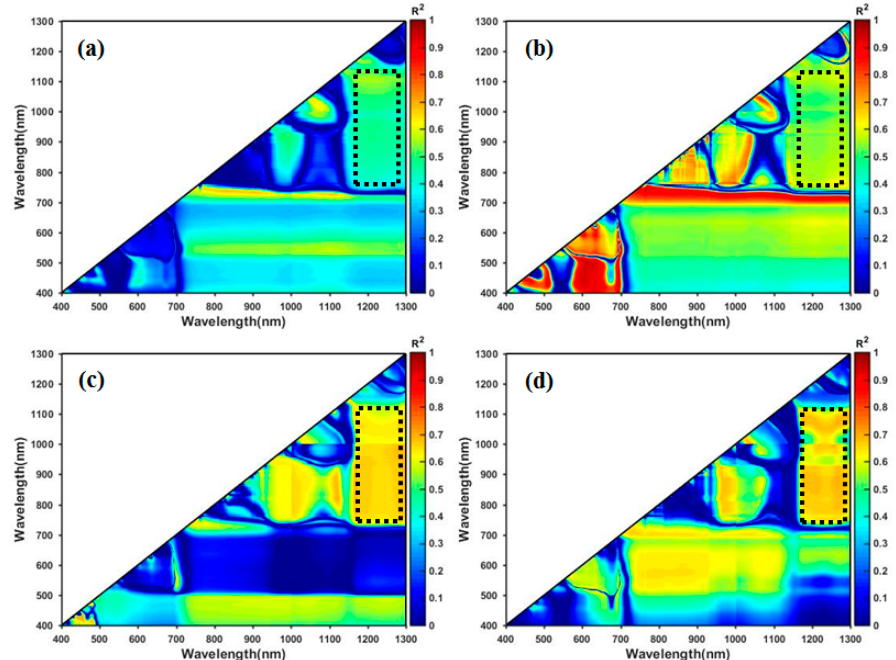
Figure 5. The coefficient of determination (R 2 ) between AGB and NDVI-like indices at four different stages: ( a ) seeding stage; ( b ) bolting stage; ( c ) flowering stage; and, ( d ) pod stage.